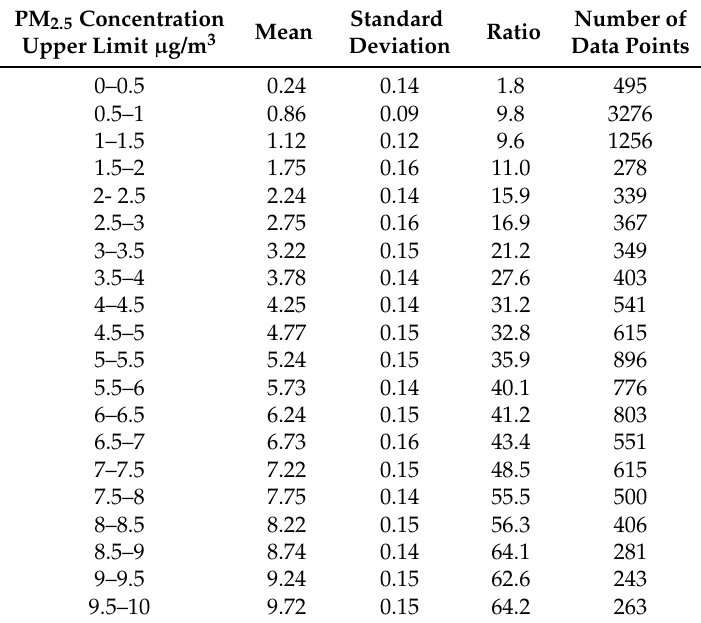
Table A6. PM 2.5 concentration range, the mean and the standard deviation of the PM 2.5 concentrations within that range, the ration of the mean and the standard deviation and the number of data points used for the calculations for Sensirion SPS030. The Lower limit of detection with Wallace et al. [65] method is defined as the PM 2.5 concentration above which the ratio is > 3.